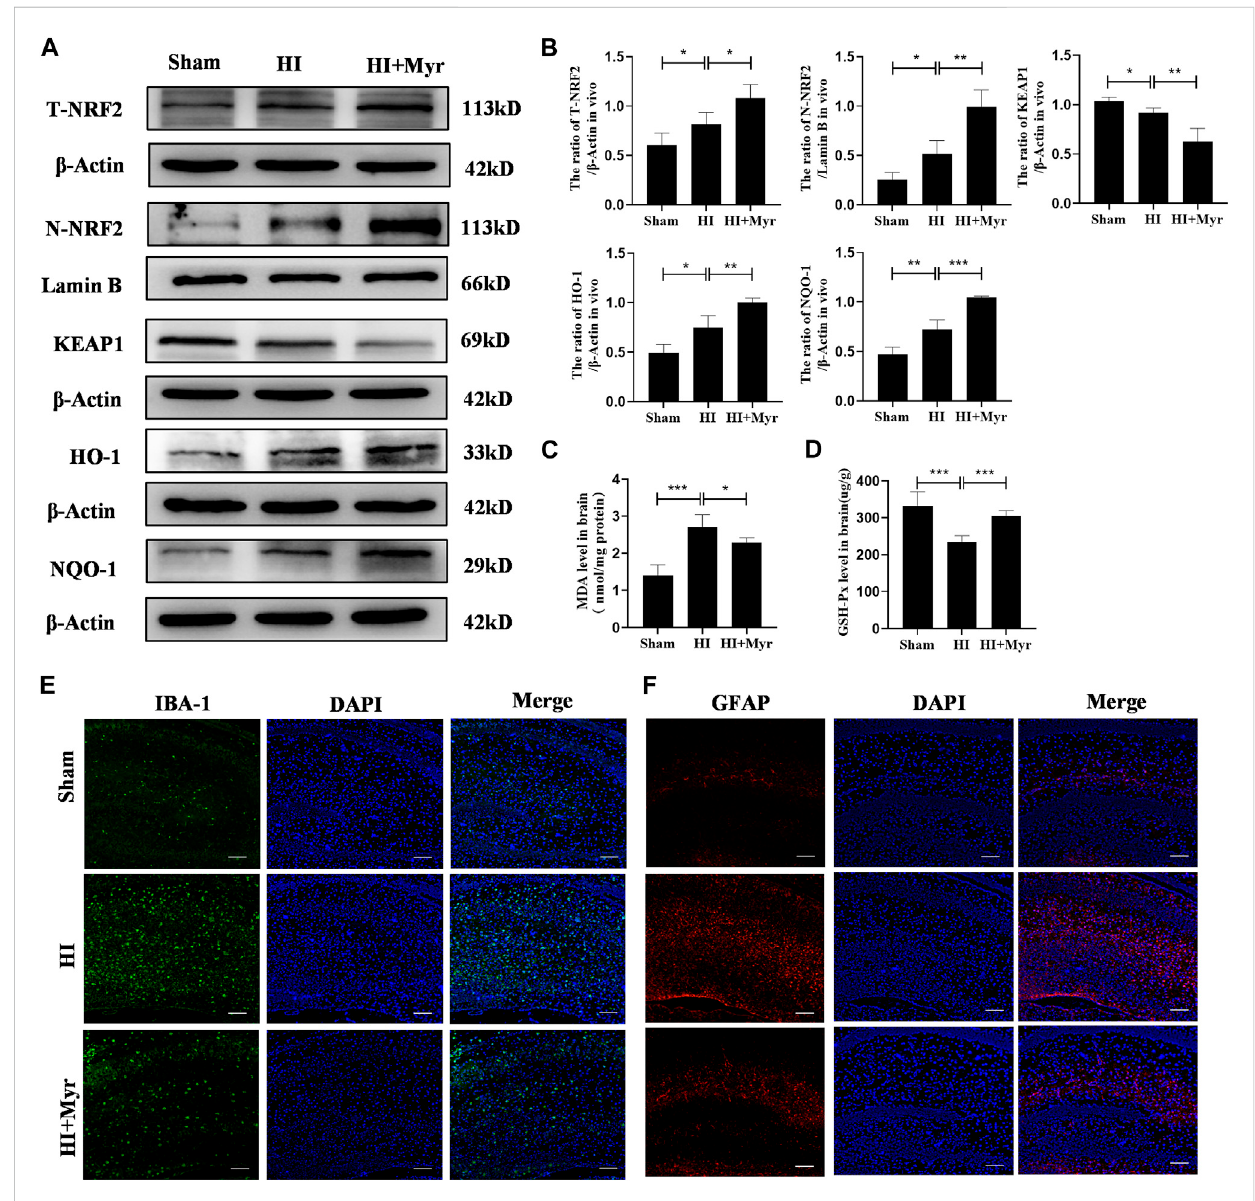
FIGURE 5 Myricetinattenuatedexcessiveoxidativestress(ROS)andreducedglialactivationthroughNRF2pathway. (A) TheproteinbandsofT-NRF2,N-NRF2, KEAP1, HO-1, and NQO-1 were evaluated by Western blot in brain tissues 24 h after HI injury. (B) Quantitative analysis of Western blot bands ( n = 4 per group). (C) TheMDAlevelinbraintissues24 hafterHIbraininjury( n =5pergroup). (D) TheGSH-pxlevelinbraintissues24 hafterHIbraininjury( n =5per group). (E) The representative immuno fl uorescence staining images of IBA-1 (green). Nucleus were stained with DAPI (blue). (F) The representative immuno fl uorescence staining images of GFAP (red). The data are presented as mean ± SD. * p < 0.05, ** p < 0.01, *** p < 0.001. Scale bar: 100 μ